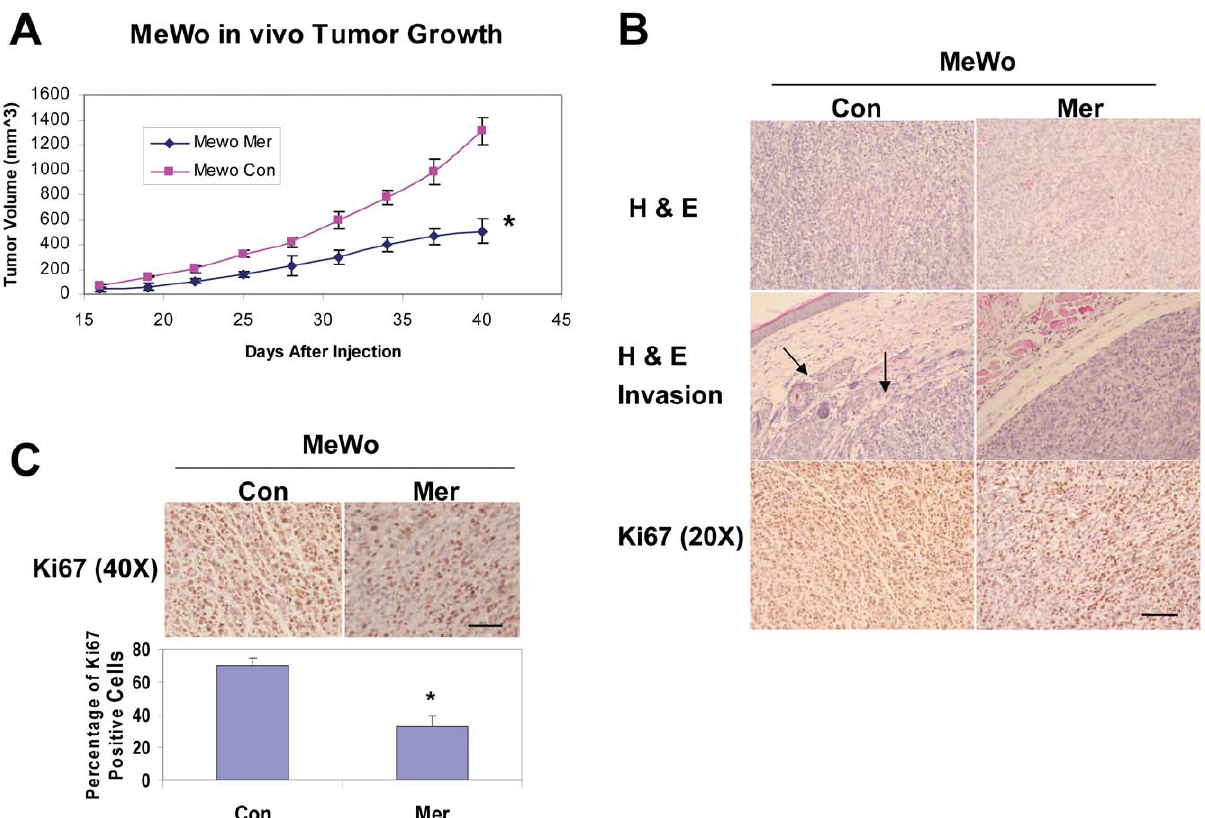
Figure 5. Increased merlin levels inhibit in vivo melanoma growth and invasion. A , Subcutaneous growth rates of the melanomas derived from 1 6 10 6 transduced MeWo cells as indicated. Numbers are the mean tumor volumes (mm3) + / 2 SD. *= p -value , 0.05, n=6. B , H&E and IHC staining with an anti-Ki67 antibody of the tumor sections derived from MeWo Mer or MeWo Con cells. Bar, 200 m m. C , Quantification of the percentage of Ki67 positive cells in the tumor sections derived from MeWo Mer and MeWo Con cells. Bars represent the means of 15 randomly selected 40X microscopic fields. *denotes a p -value , 0.05. Bar, 200 m m.